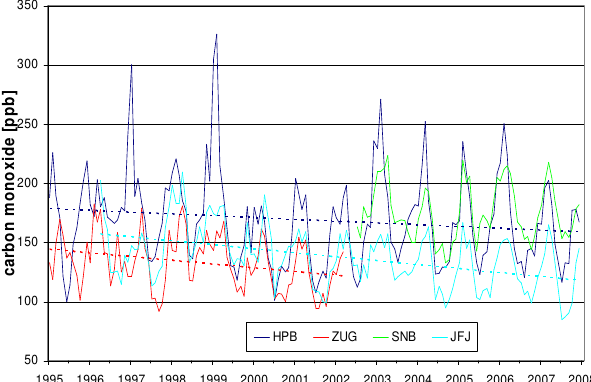
for the different seasons at the respective „DACH“ sites; 4 3